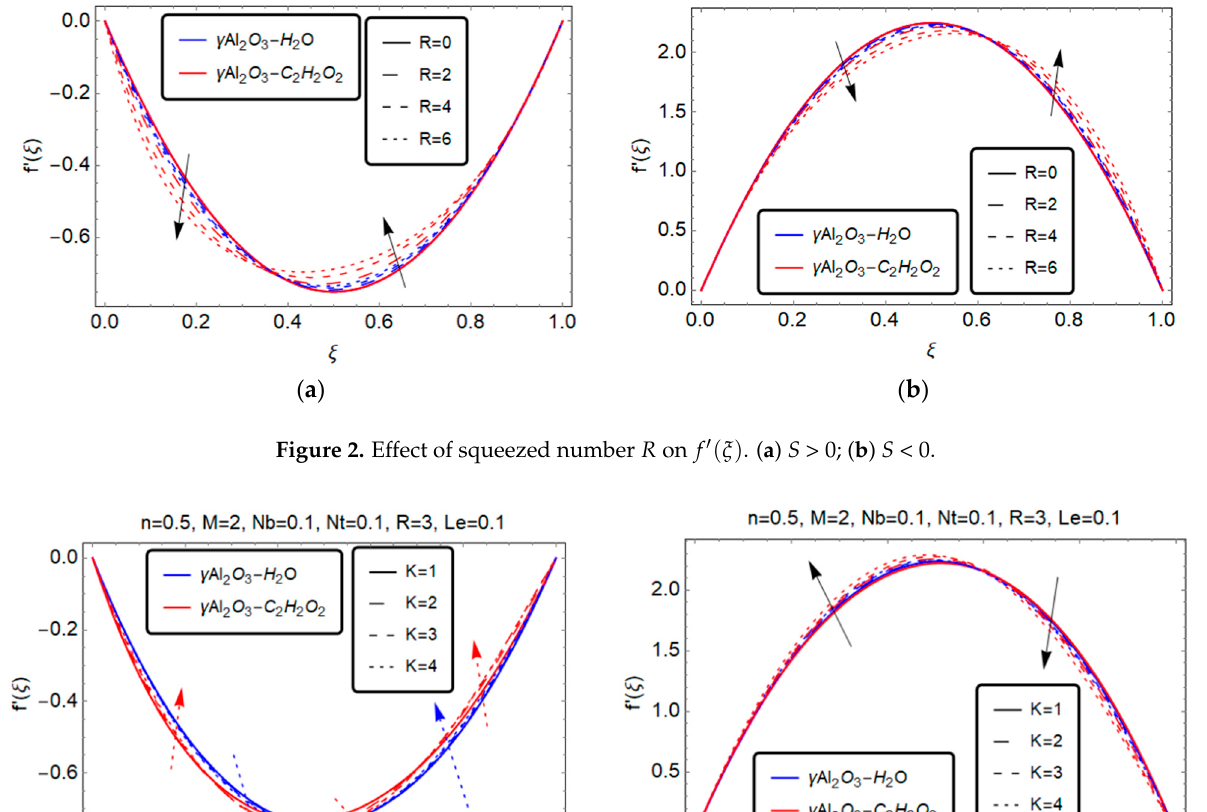
Figure 3a. In the case of injection, an opposite behavior is observed.